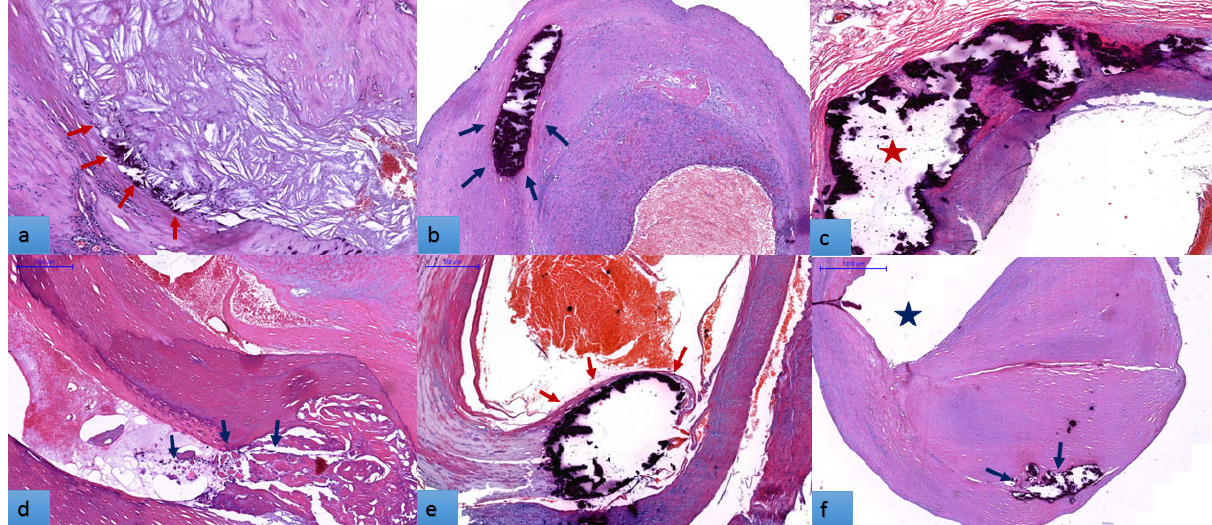
Figure 3. Calcification pattern in carotid plaques, H&E stain: Decalcified specimens from different cases show a various aspects and extension of mineral mass. ( a ). Large lipid core with sheet-like microcalcification forming a calcification front within fibrosis. (red arrows). Mononuclear inflammatory infiltrate is more abundant in the area around calcified foci; ( b ). nodular calcification with smooth rounded edges in the thickness of the fibrohyaline plaque (blue arrows); ( c ). plaque with heterogeneous structure, largely occupied by extensive calcification formed by conglomerated mineral nodules with irregular margins, extending towards the luminal surface of the plaque (red star); ( d ). plaque with large hyalinized areas in which osteoid metaplasia (trabecular bone and bone marrow foci) is also observed (blue arrows); ( e ). calcified nodule located at the intimal–luminal interface (red arrows), covered by thin fibrous cap (superficial calcification); ( f ). fibrous plaque with deep calcifications located in the thickness of the media (blue arrows, vascular lumen marked by star). Bar represents 500 µ m in all of the tissue